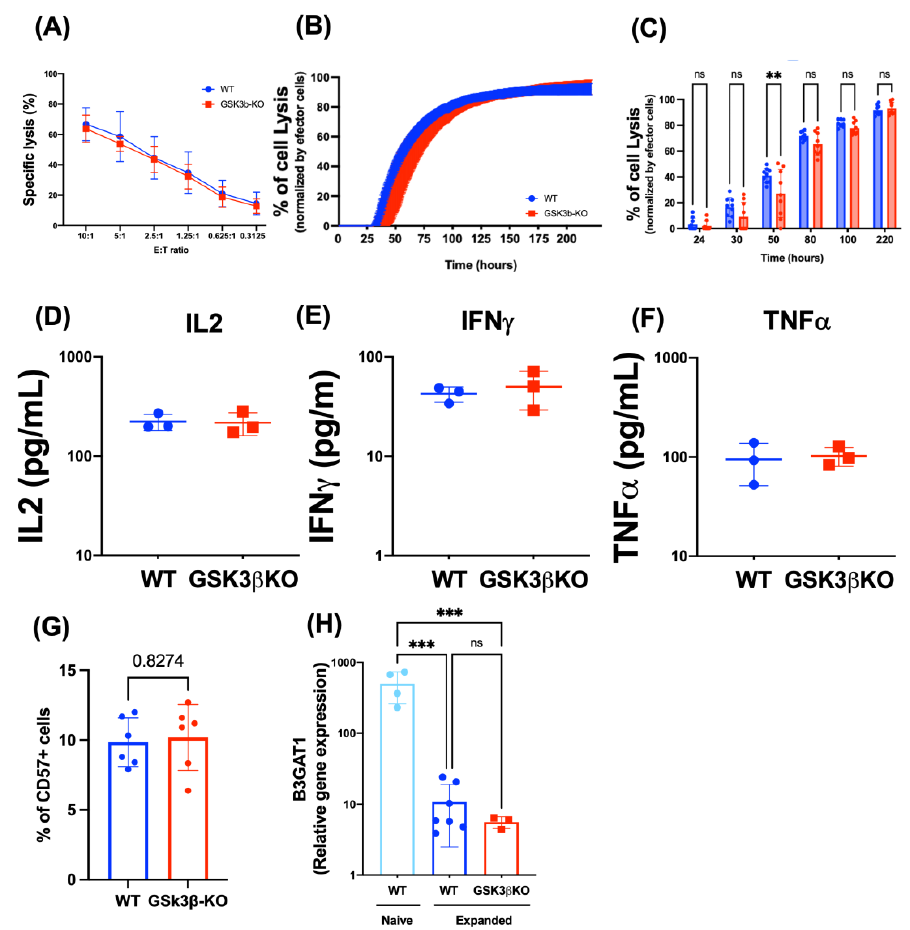
Figure 2. Deletion of GSK3B did not alter antitumor activity or maturation of FC-21 expanded NK cells. Both WT and GSK3B -KO NK cells were cocultured with Kasumi1 (AML tumor cell line) for 4 ( A ) or 220 h ( B , C ). “B” time course of long-term cell killing and “C” bar graph representative of indicated hours; ( n = 3). ( D – F ) IL2, IFN 𝛾 and TNF 𝛼 release was assessed after 4 h of WT and GSK3B -KO NK cells with PHA ( n = 3). ( G ), CD57 expression was evaluated by flow cytometry on FC-21 expanded WT and GSK3B -KO NK cells ( n = 6). ( H ), B3GAT1 expression in WT, FC-21 expanded WT, and FC-21 expanded GSK3B -KO NK cells as measured by RNA-seq. ns = non-significative, ** p ≤ 0.01, *** p ≤ 0.001. See also supplementary Figure S3 for cytotoxicity against other cancer cell lines, and supplementary Figure S4 for representative CD57 gating.